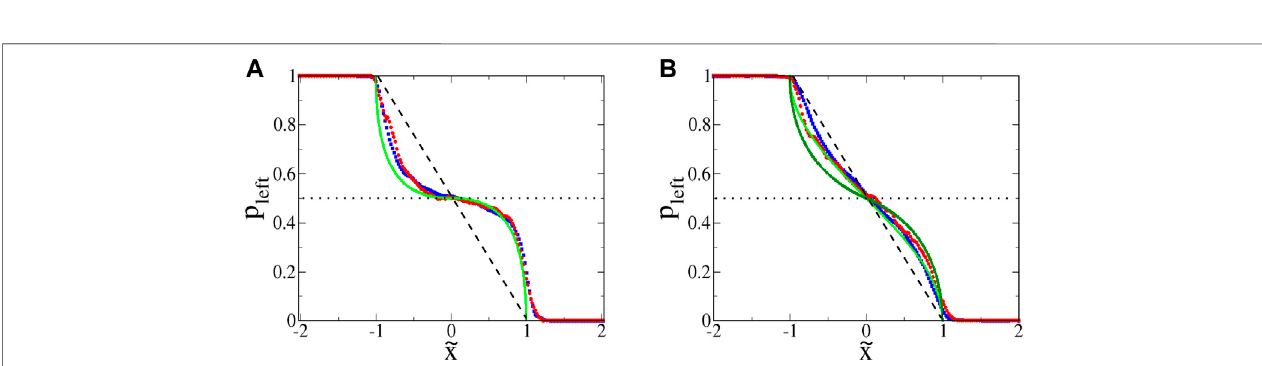
FIGURE 9 | : Probability p left for swimming microbes to move leftward, given a starting location ~ x . (A) Euglena in fl ow with A = 1.8s − 1 (blue squares) and A = 7.2s − 1 (red circles). The theoretical curve (from Ref. [34]) for perfectly smooth swimmers with α = 1 is shown in green. The theoretical curve for α = 0.8 is indistinguishable from the green curve. (B) Tetraselmis in fl ow with A = 1.8s − 1 (blue squares) and. A = 3.6s − 1 (red circles). The theoretical curve for perfectly smooth swimmers with α = 0 is showninlightgreen,andthetheoreticalcurvefor α =0.3isindarkgreen.Thedasheddiagonallineisincludedtoillustratedeviationsoftheprobabilitiesfromalinear relation between the SwIMs at ~ x (cid:1) ±